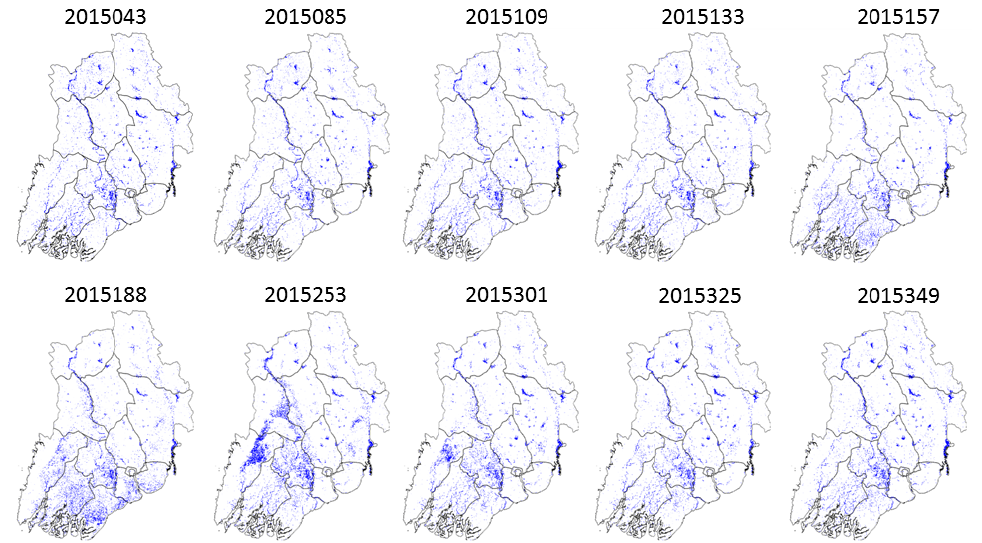
Figure 11. Inundation patterns in the Irrawaddy Delta region of Myanmar using dense time series Sentinel-1.